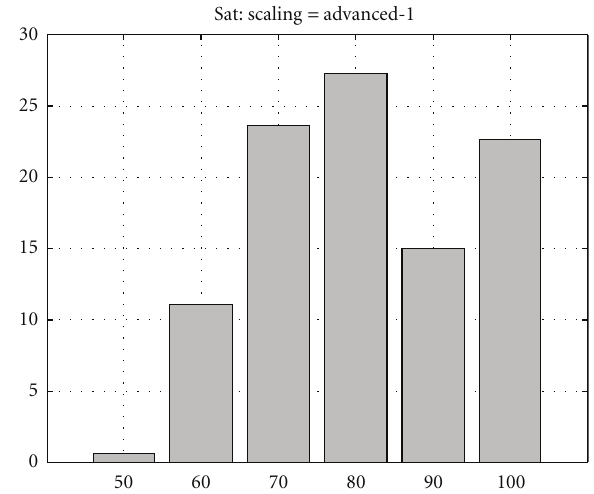
Figure 11: Satisfaction histogram for di ff erence-oriented scaling